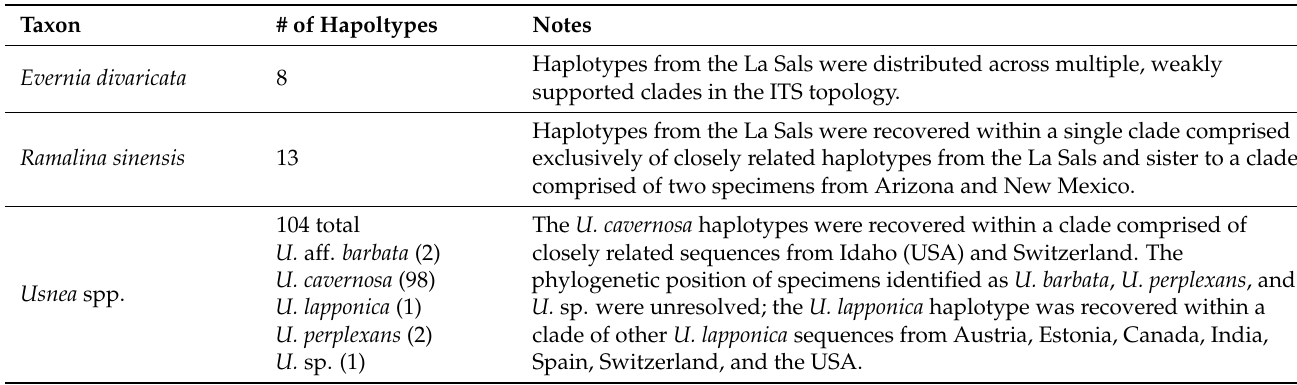
Table 3. Genetic variation in fruticose lichens occurring at a lichen-draped conifer site—“Geyser Pass 2” in the La Sal Mountains, UT, USA. The number of Usnea haplotypes of each taxon are given